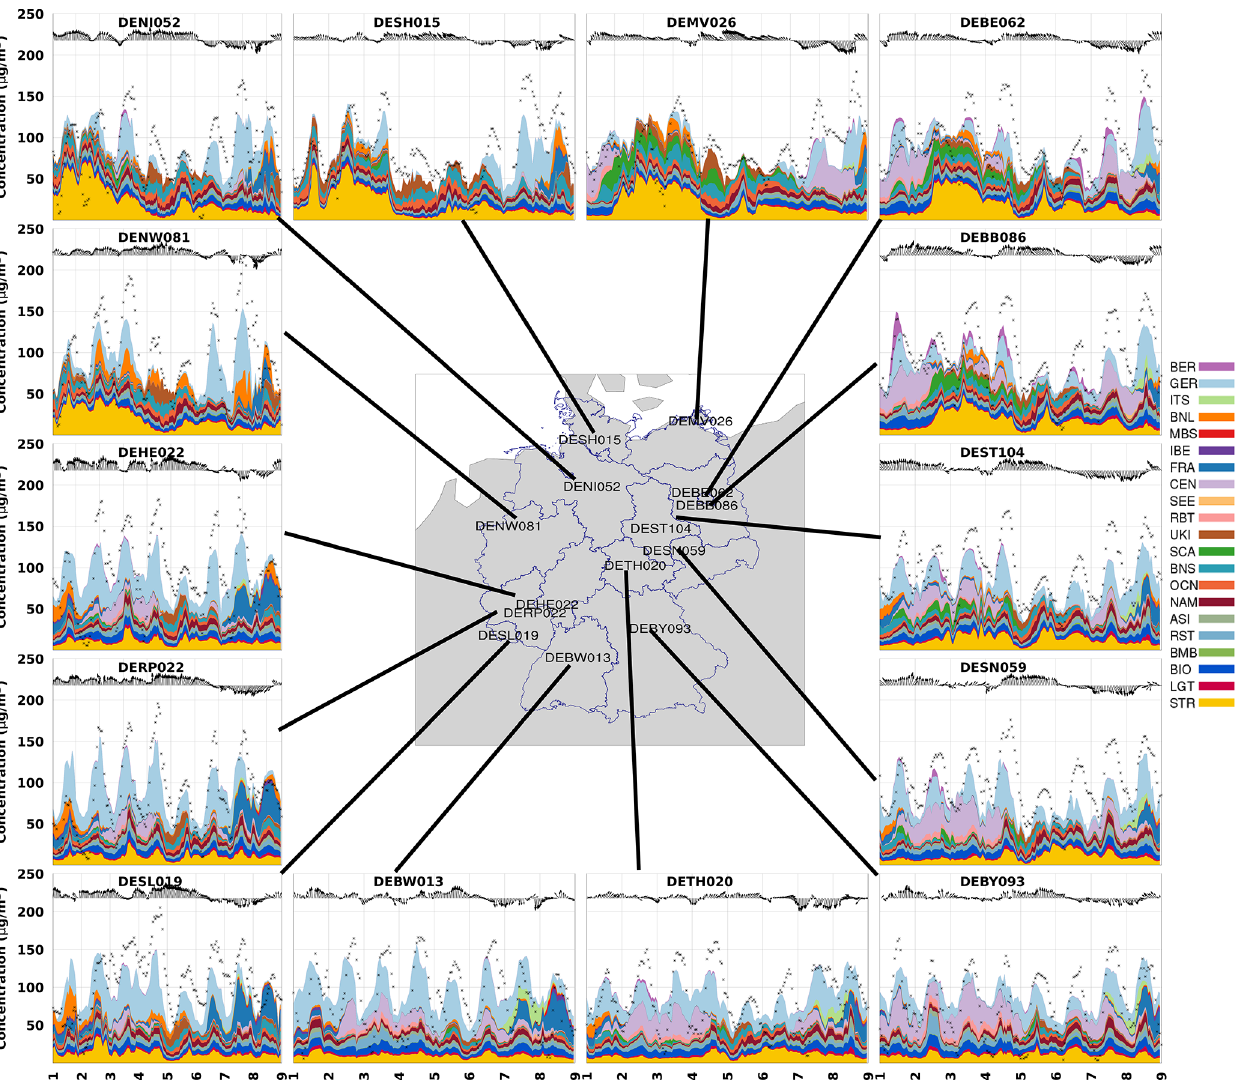
Figure 7. Contribution of regional NO x sources to hourly O 3 concentrations of local and other European sources, HTAP2 source regions, and other global source types at each station during the 1–8 August 2018 period. In addition, the vectors along the top of each panel represent the calculated wind speed and direction at 10ma.g.l. The black dots represent the observed O 3 concentrations.